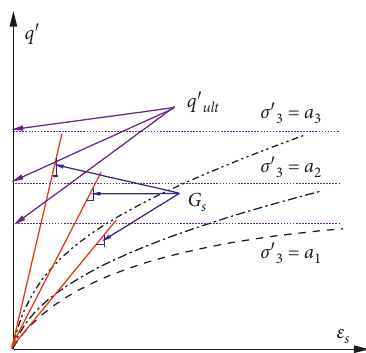
Figure 9: Schematic stress-strain curves for the triaxial shear test. Figure 10: The ε